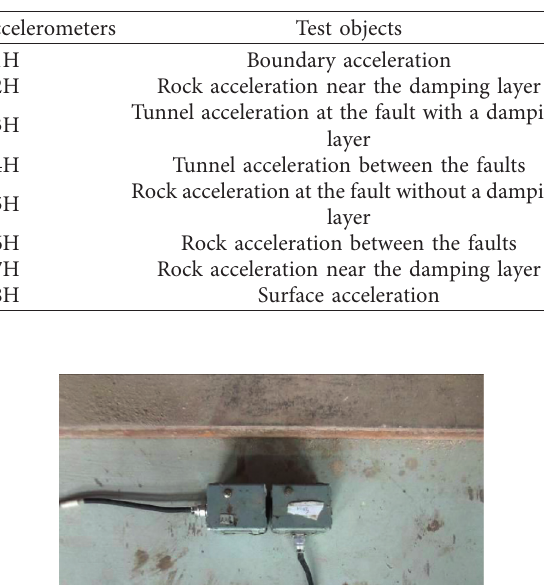
Table 1: Accelerometers and test objects.